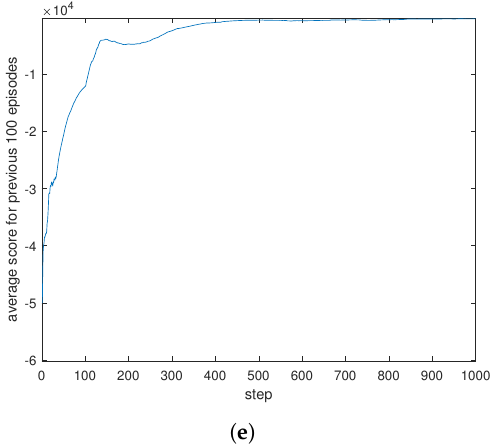
Figure 6. Performances of the proposed method for path-following and obstacle avoidance con- trol. ( a ) Comparison of paths for following. ( b ) Errors in path-following. ( c ) Inputs for path- following. ( d ) Scoring for each step with proposed method. ( e ) Average scoring for each episode with proposed